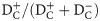
Selection of donor ability in structured populations.A: Experimental setup. D+ (good donor, red) and D− (nondonor, blue) strains are competed. 2.5% of D+ and D− cells initially carry C plasmids (bright colours), while 97.5% do not (pale colours). The population m is a single well-mixed population; metapopulation s consists of two subpopulations, s1 and s2, with initial D+/D− ratios of 1/9 and 9/1. After growth and transfer (t0 to t1), subpopulations from s are pooled and cells are grown to saturation with or without antibiotic (Cm) selection (t1 to t2). The proportions of different cell types are represented schematically and do not correspond to actual numbers. B: Selection of D+
strain. The frequency of the good donor D+ is shown for s (black) and m (green) populations, with (plain lines) or without (dashed lines) Cm antibiotic during the selection phase. Good donors are only selected for in the s metapopulation, in the presence of antibiotic. C: Plasmid dynamics. Plasmid frequency in each population is shown for the transfer phase (from t0 to t1), in each of m, s1, and s2 populations. Plasmids spread mostly in the s2 subpopulation, enriched in the better donor, D+. D: Transfer bias. The proportion of C plasmids present in D+ strain, DC+/(DC++DC−) is shown as a function of time for s and m populations (same colour scheme as in B panel). C plasmids get enriched in the better donor D+ strain during the transfer phase, for the structured population s. All results are shown as means ± SEM. (N ≥ 6). Data are available from FigShare at http://dx.doi.org/10.6084/m9.figshare.3199252.